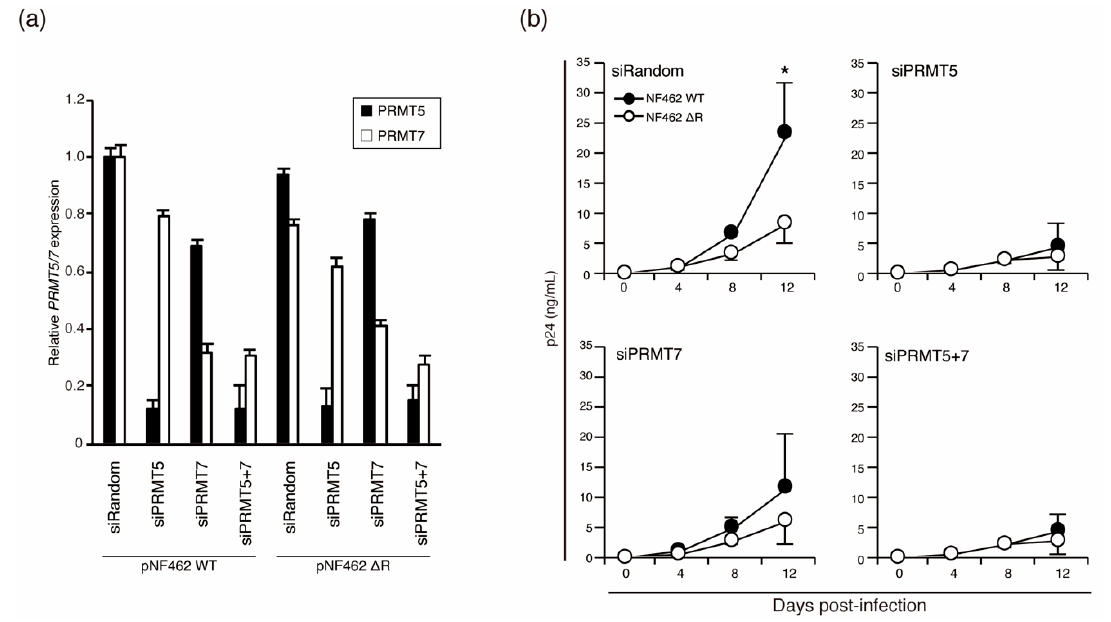
Figure 4. Knockdown of PRMT5 and PRMT7 in MDMs affects virus production. ( a ) Expression of PRMT5 and PRMT7 at 12 days post-infection was measured by qPCR. The experiments were independently conducted in triplicate. ( b ) MDMs were transfected with siPRMT5 and siPRMT7, and then infected with NF462 WT or NF462 Δ R strains of HIV-1. Virus production was measured using p24 ELISA at 0, 4, 8, and 12 days post-infection. Statistically significant differences are indicated by single asterisks (* p < 0.05).